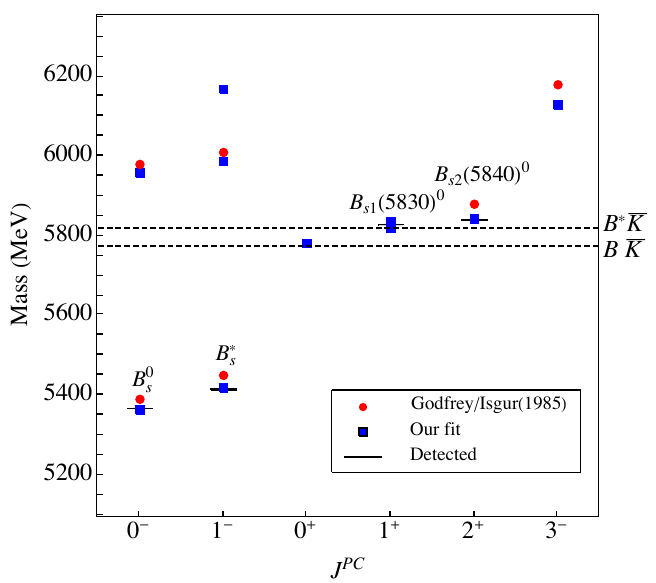
Figure 1 . Mass spectrum of bare ¯ bs mesons within the relativized quark model. The circles and squares are the results predicted in ref. [4] and our new fit, respectively. The shaded areas represent the experimental masses and their uncertainties